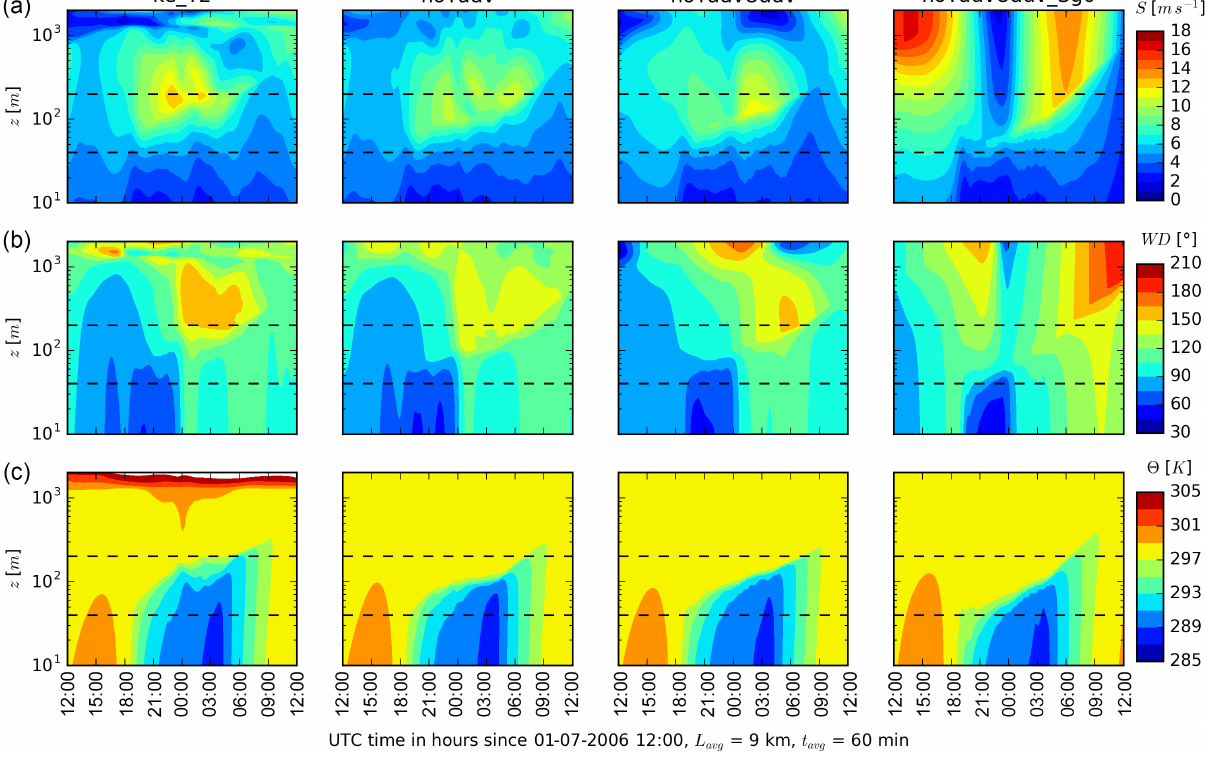
Figure 10. Time–height contour plots of wind velocity S (top raw), wind direction WD (middle) and potential temperature (cid:50) (bottom) for four k - ε SCM simulations: with all the forcing terms (first column), without (cid:50) adv (second), without (cid:50) adv , U adv , and V adv (third), and without advection, and assuming that the geostrophic wind only varies with time following the surface pressure gradient S g0